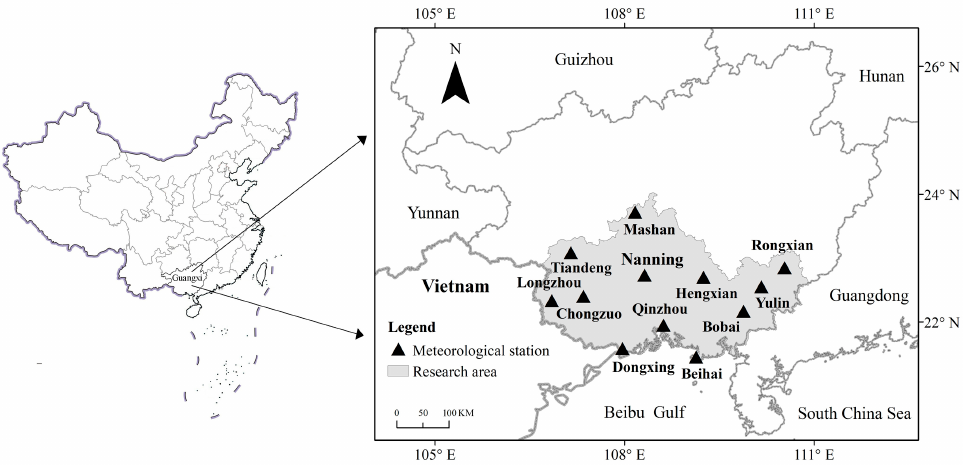
Figure 1. The location of the Beibu Gulf and 12 rain-gauge stations in this area.